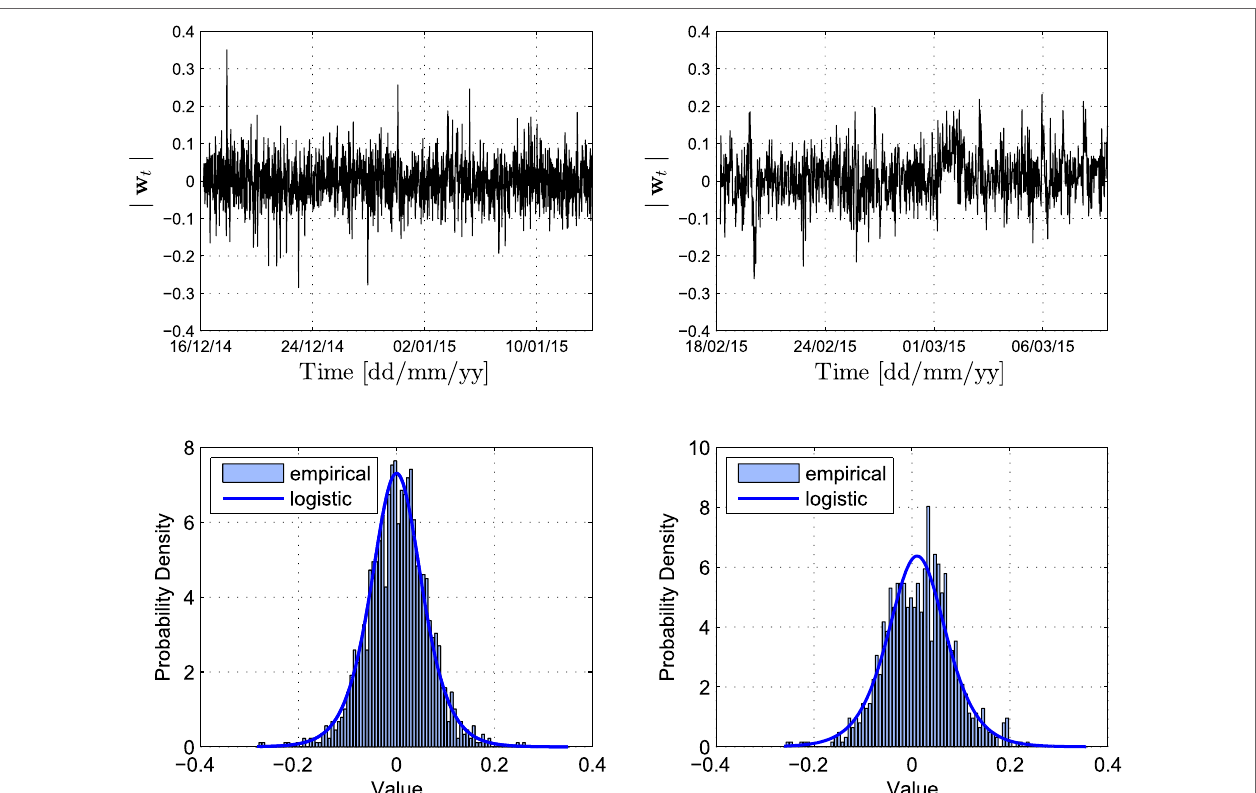
FIGURE 11 | Top: VAR prediction error for the estimation (left) and validation set (right) of sensor F2 . Bottom: histograms and fitted distribution of the prediction error for each